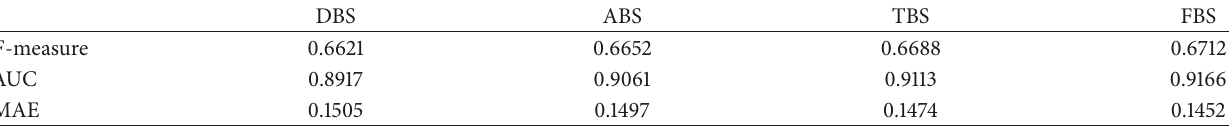
Table 2: 𝐹 -measure, AUC, and MAE of DBS, ABS, TBS, and FBS.